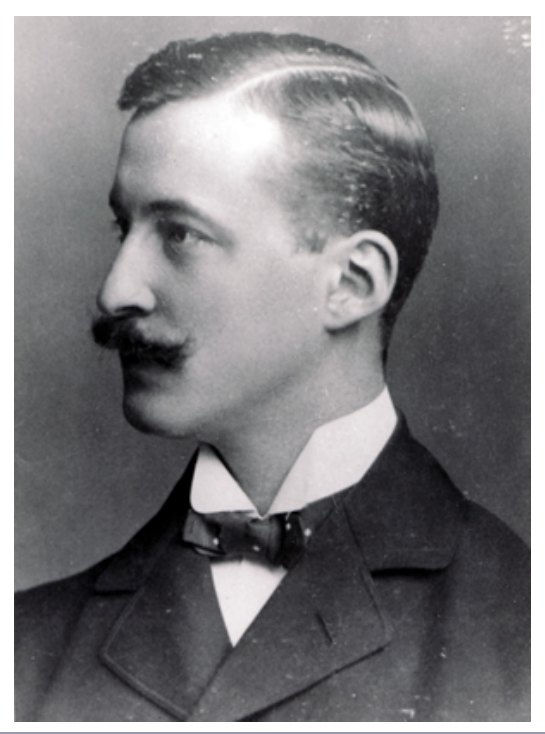
Fig. 2 . Portrait of Günter Tessmann in 1906. ©